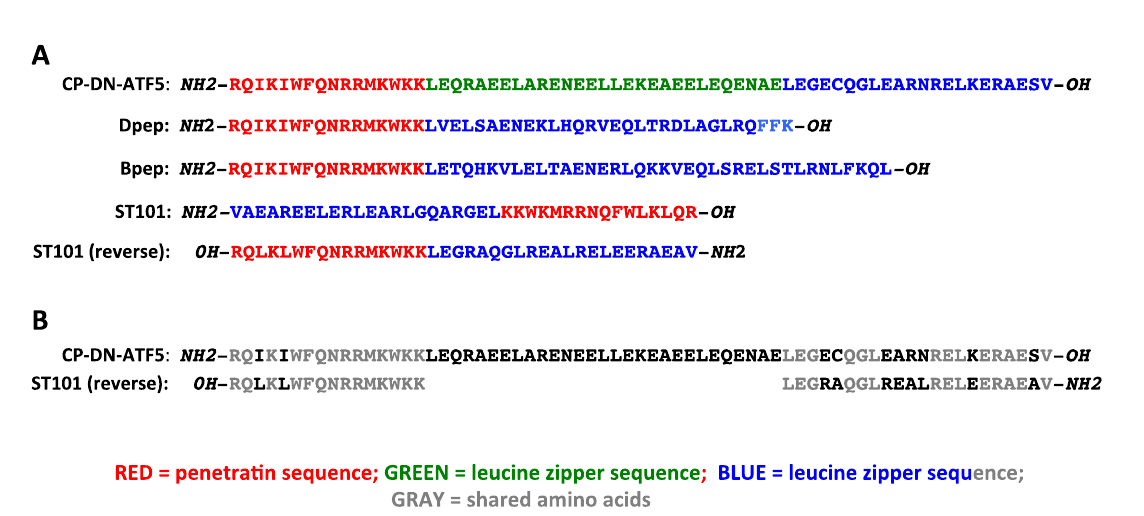
Figure 3. Comparison of the sequences of CP-DN-ATF5, Bpep, Dpep and ST101. A . Sequences of each of the peptides. The various domains of each peptide are denoted in the color schemes given in the figure. Note that ST101 is composed of D-amino acids. The reverse sequence is also shown. B . Comparison of the reverse sequence of ST101 with CP-DN-ATF5.